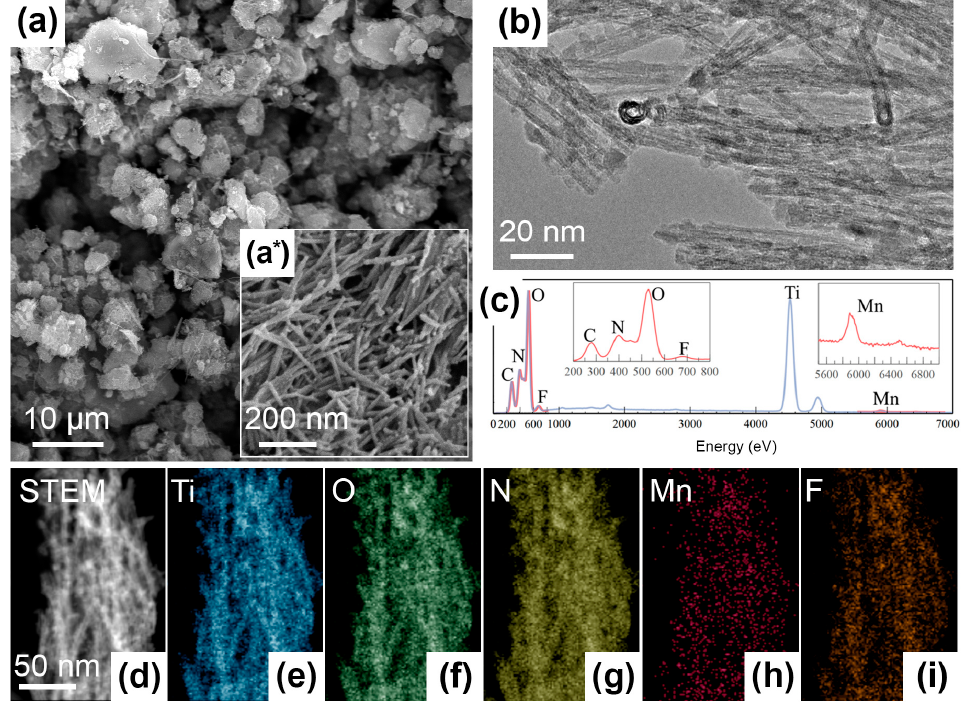
Figure 1. Morphology and elemental analysis for Mn, F, N co-doped TiO 2 : ( a , a* ) SEM- and ( b ) STEM-images of the TO-Mn/F/N-04 sample, ( c ) EDX-spectrum and ( d – i ) elemental mapping for the TO-Mn/F/N-02.